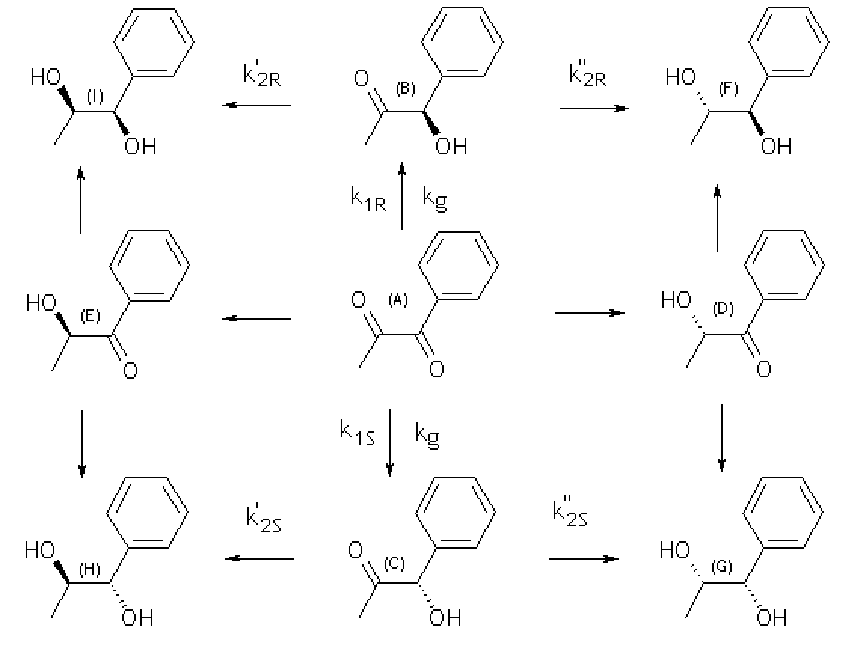
( R )-1-hydroxy-1-phenyl-2-propanone; ( C ) ( S )-1-hydroxy-1.phenyl-2-propanone; ( D ) ( S )-2- hydroxy-1-phenyl-1-propanone; ( E ) ( R )-2-hydroxy-1-phenyl-1-propanone; ( F ) (1 R ,2 S )-1- phenyl-1,2-propanediol; ( G ) (1 S ,2 S )-1-phenyl-1,2-propanediol; ( H ) (1 S ,2 R